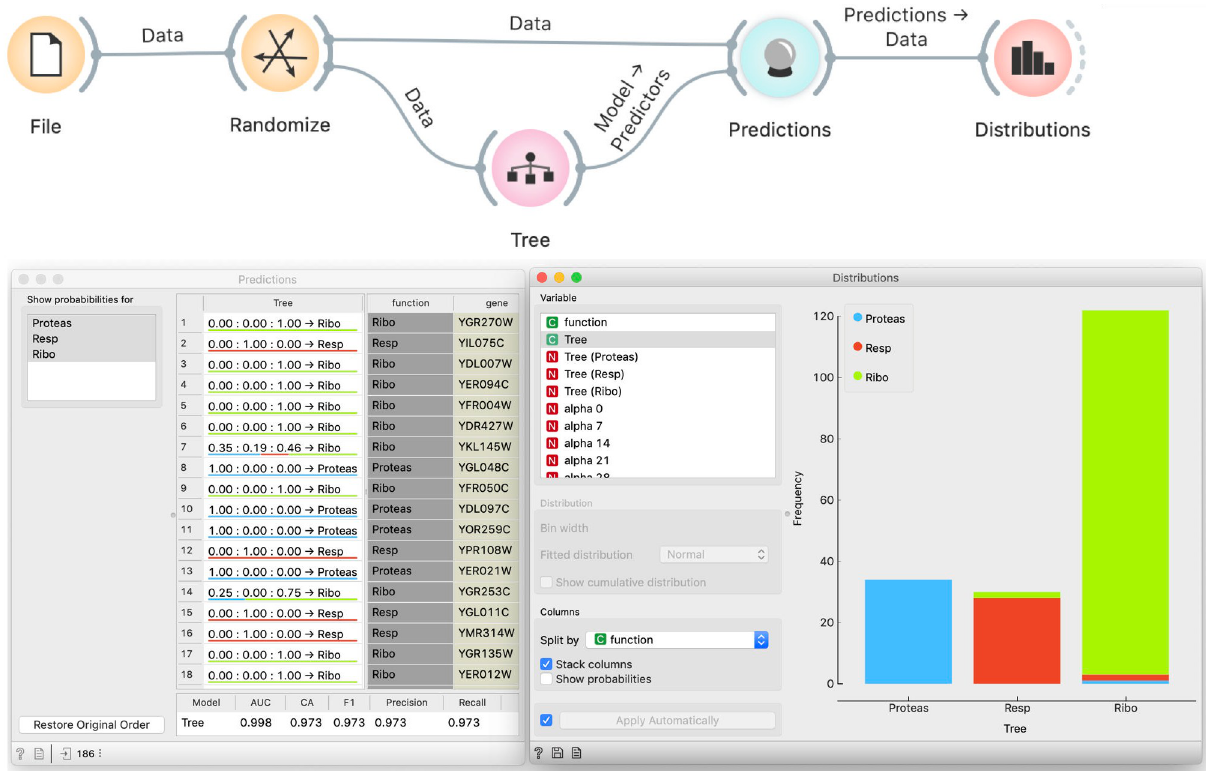
Fig 3. Modeling from permuted data. Permutation of class labels should prevent successful modeling, yet the Distribution widget and the scores at the bottom of the Prediction widget show that the tree almost perfectly fits the data.